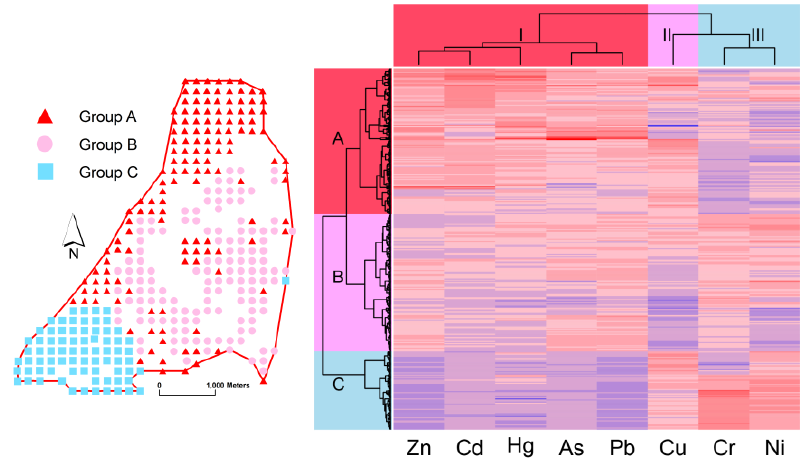
Figure 5. Dendrogram results of hierarchical cluster analysis for metals and soil samples. Grids in a row with blue-to-red color gradient represents the concentration of metals varied from low to high in a topsoil sample .